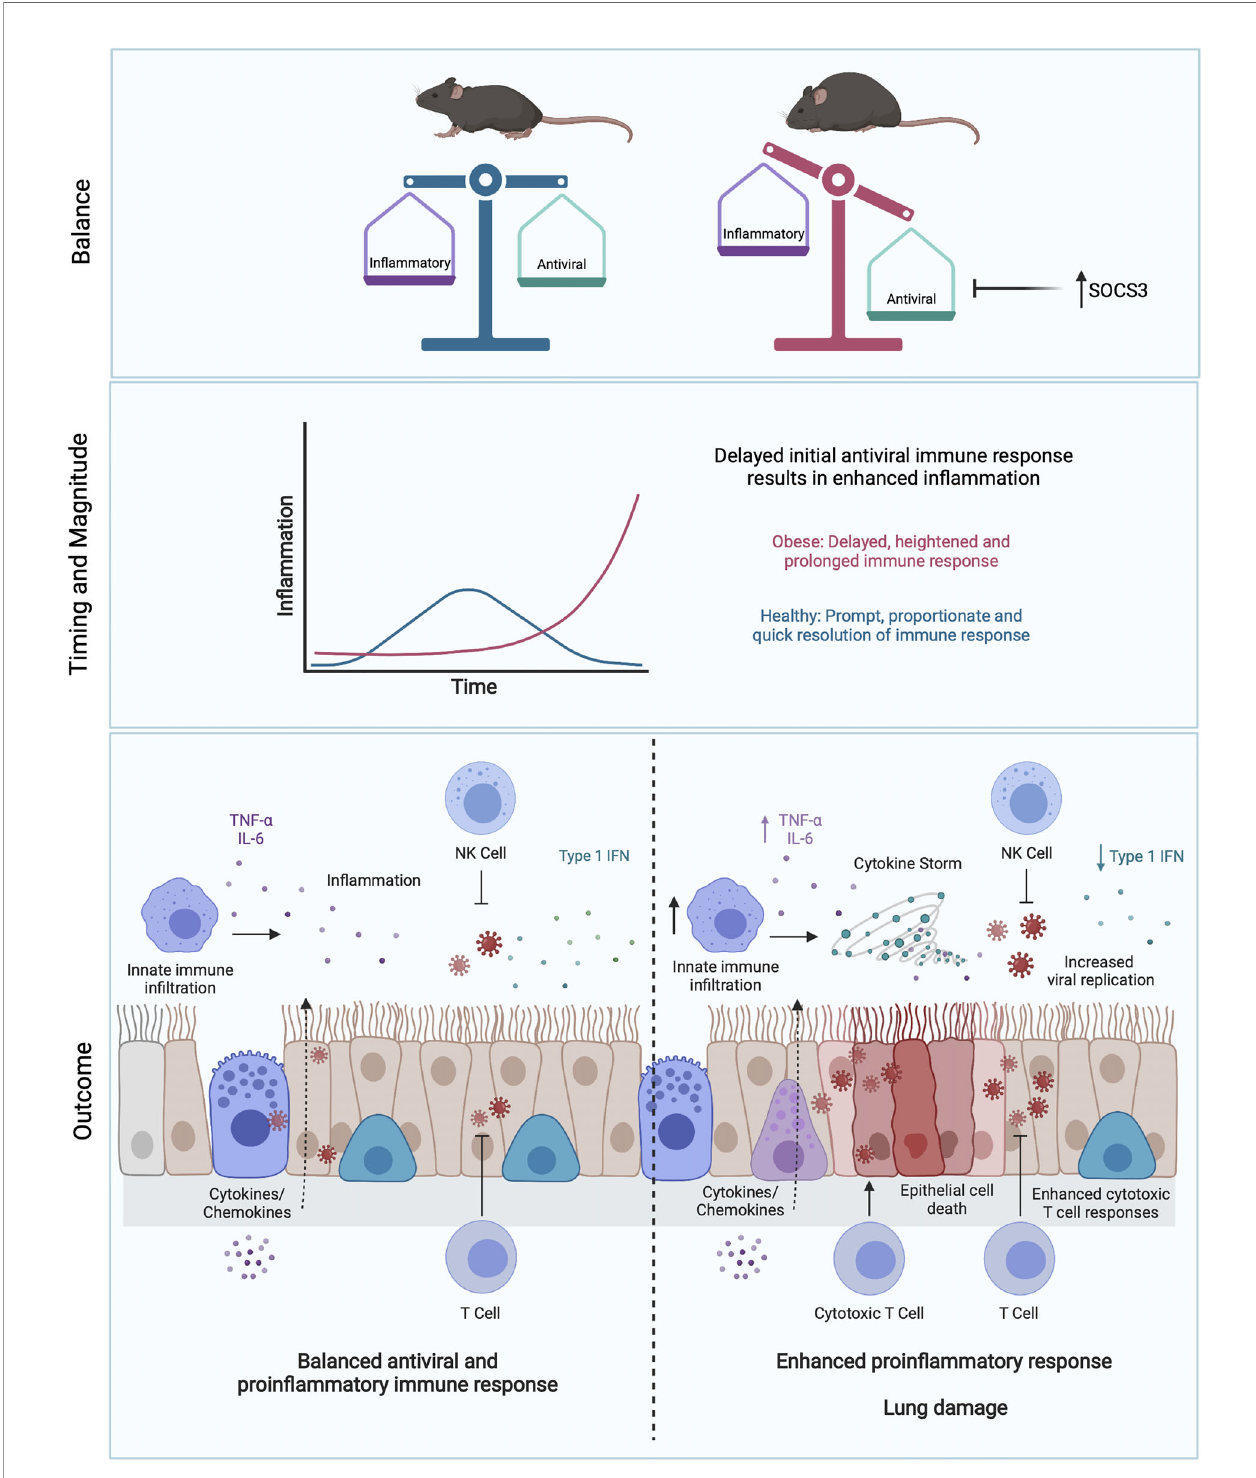
FIGURE 3 | Obesity skews the balance between antiviral and pro-in fl ammatory responses. Initial blunted interferon responses to IAV in obese individuals results in increased viral spread and replication (245). This is accompanied by enhanced pro-in fl ammatory cytokine responses, driving immunopathology in the lung (193, 194). This imbalance may be partly driven by elevated levels of SOCS3 in obesity (193, 194). Delay of early viral clearance by T cells may result in further tissue damage due to excess CTL responses. Figure created with